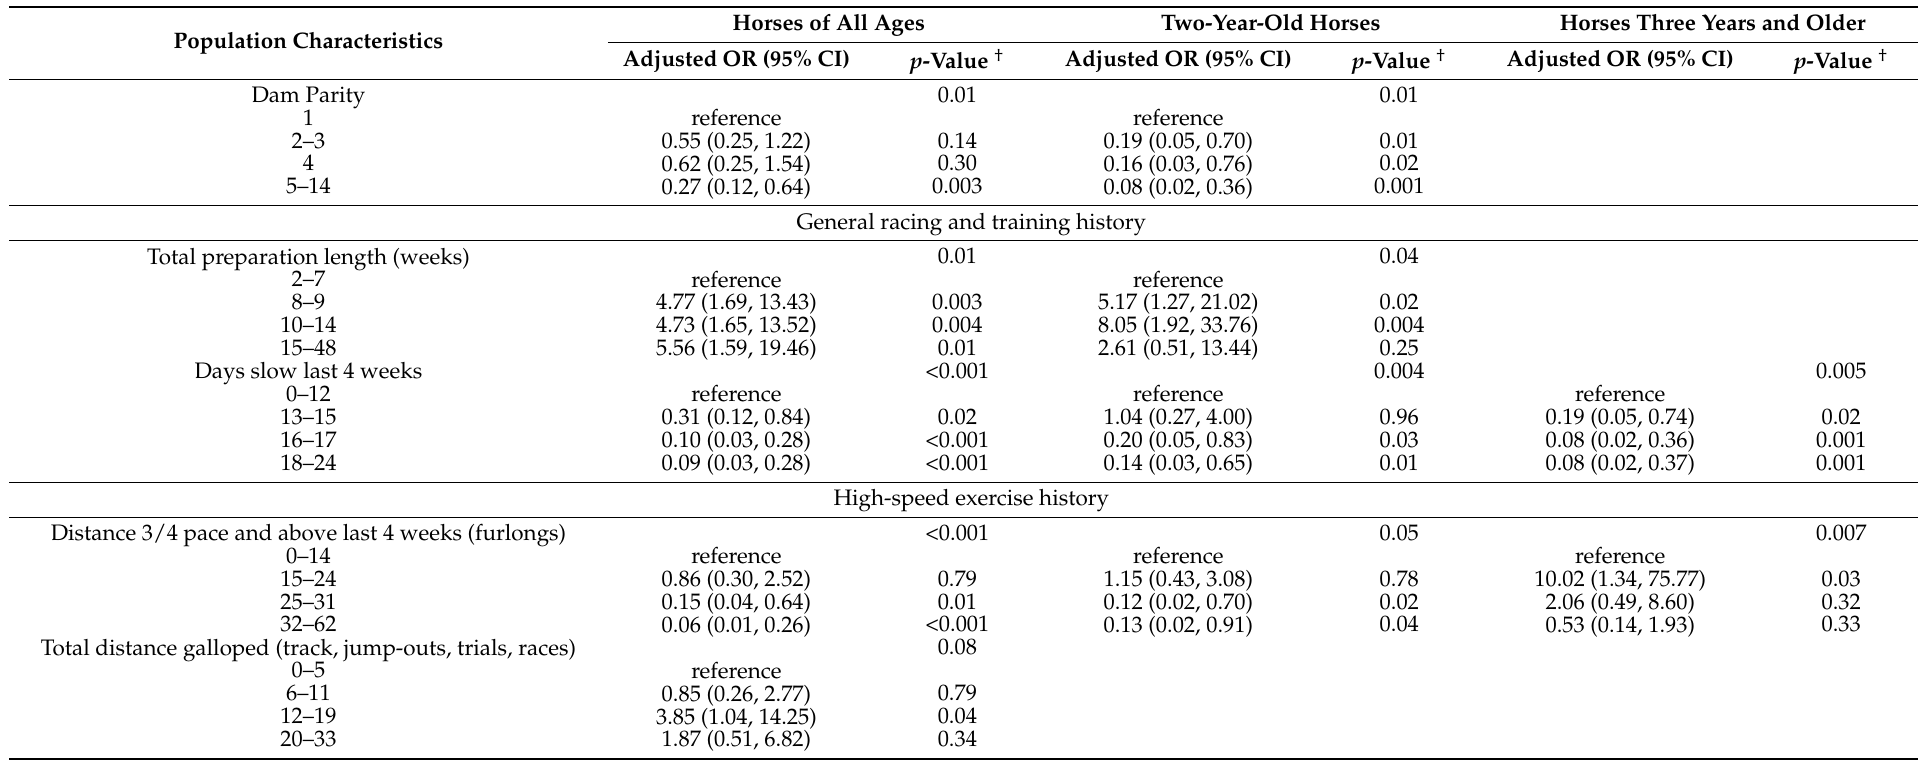
Table 3. The effect of population characteristics, general racing and training history, and high-speed exercise history on musculoskeletal injuries in Thoroughbred racehorses in South-East Queensland,